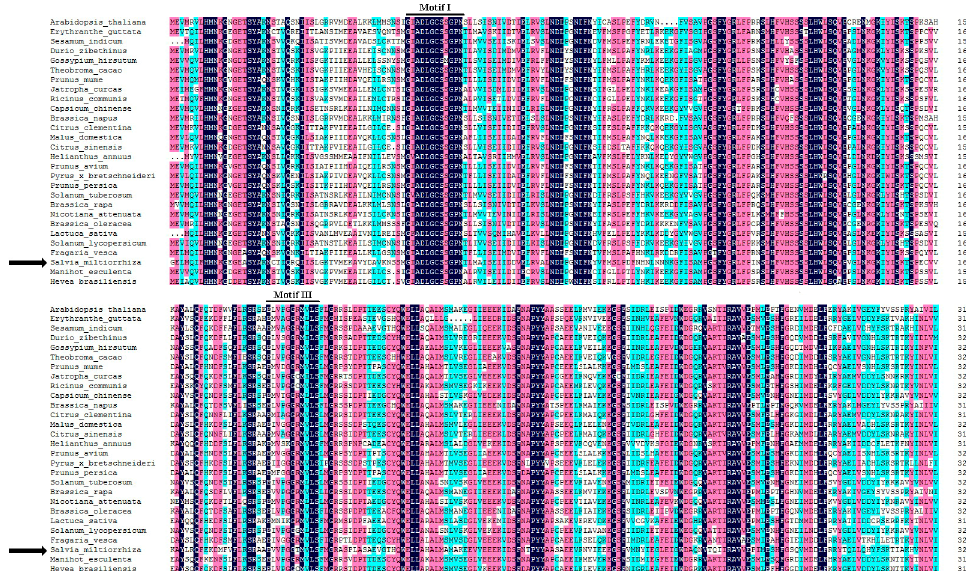
Figure 1. Multiple-sequence alignment of the jasmonic acid (JA) carboxyl methyltransferase (JMT) conserved amino-acid sequences from Salvia miltiorrhiza and selected known JMTs from other species, including the binding sites (motifs I and III are indicated) of S -adenosyl- L -methionine. The S. miltiorrhiza sequences are marked with a black arrow.